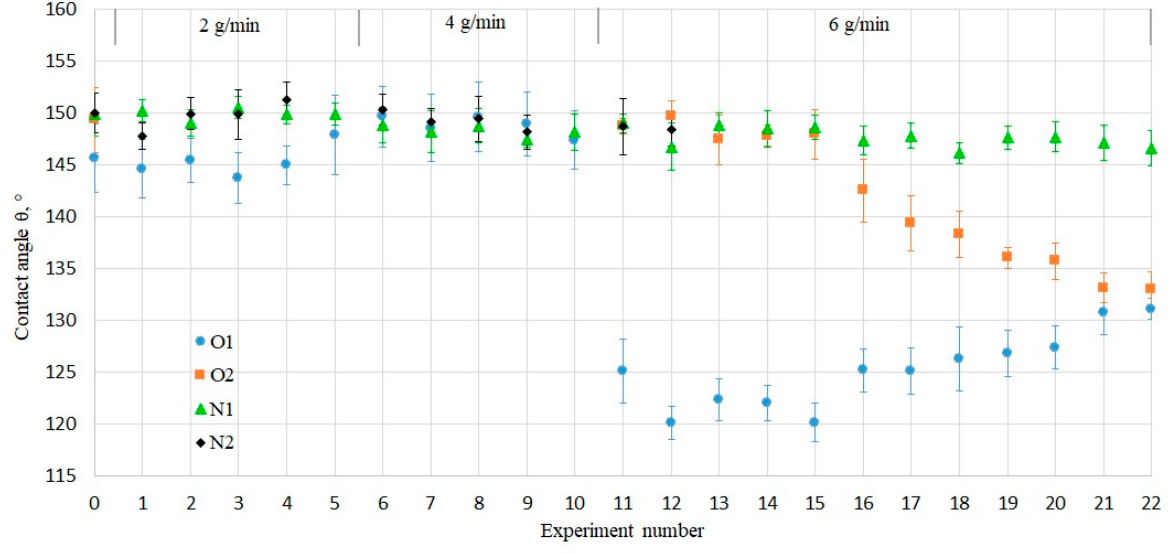
Figure 4. Water contact angles in the initial state (Exp. № 0) and after each condensation experiment for the investigated samples.